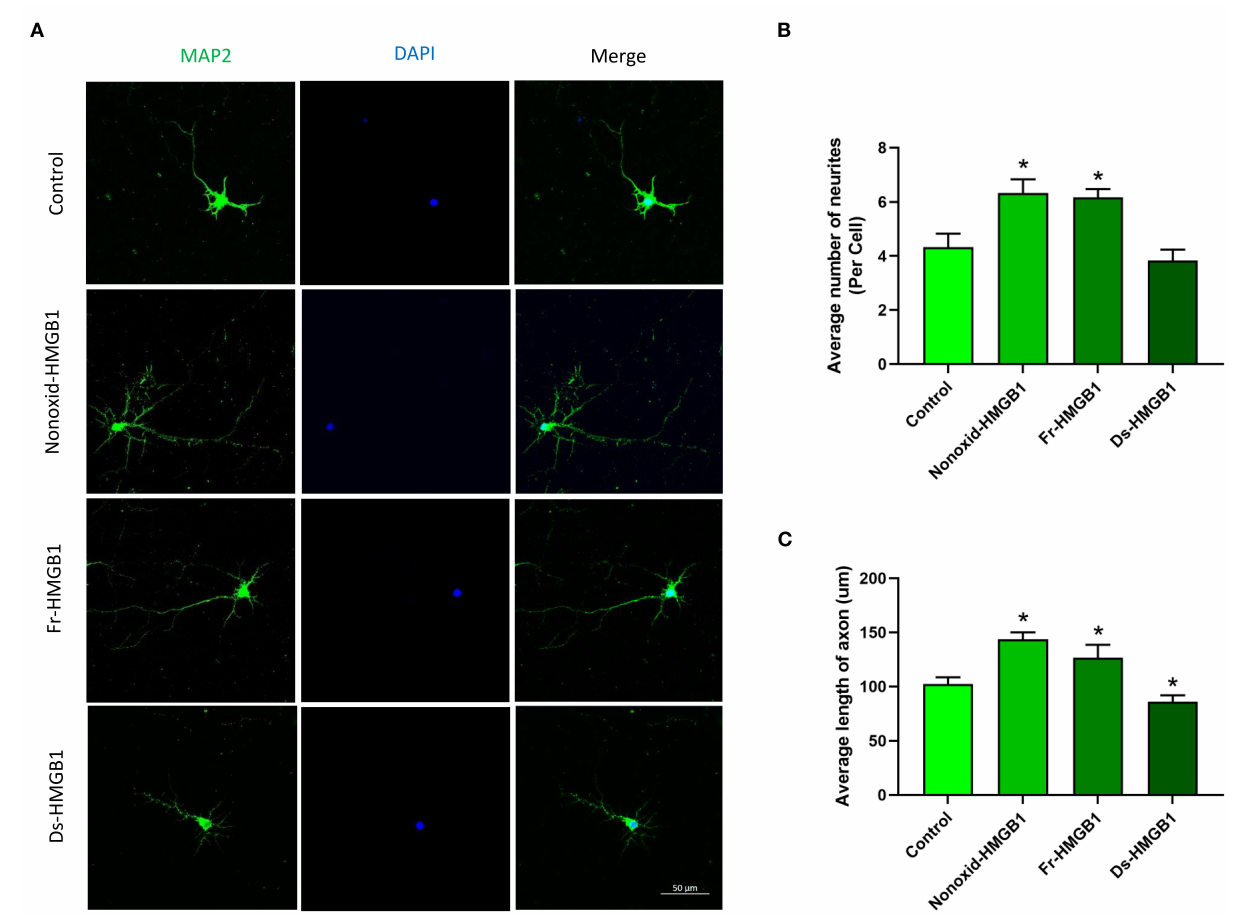
FIGURE 1 | Effects of HMGB1 in different redox forms on neurite outgrowth and axon elongation of cortical neurons. (A) Immunocytochemistry was used to label neurites and axons after 24h of treatment with HMGB1. (B) Nonoxid-HMGB1 and fr-HMGB1 significantly increased the average number of neurites compared to the control group. Ds-HMGB1 failed to significantly affect neurite outgrowth. (C) Nonoxid-HMGB1 and fr-HMGB1 significantly increased the average axon length compared to control; however, the average axon length was decreased after ds-HMGB1 treatment. Mean + SEM. * p <